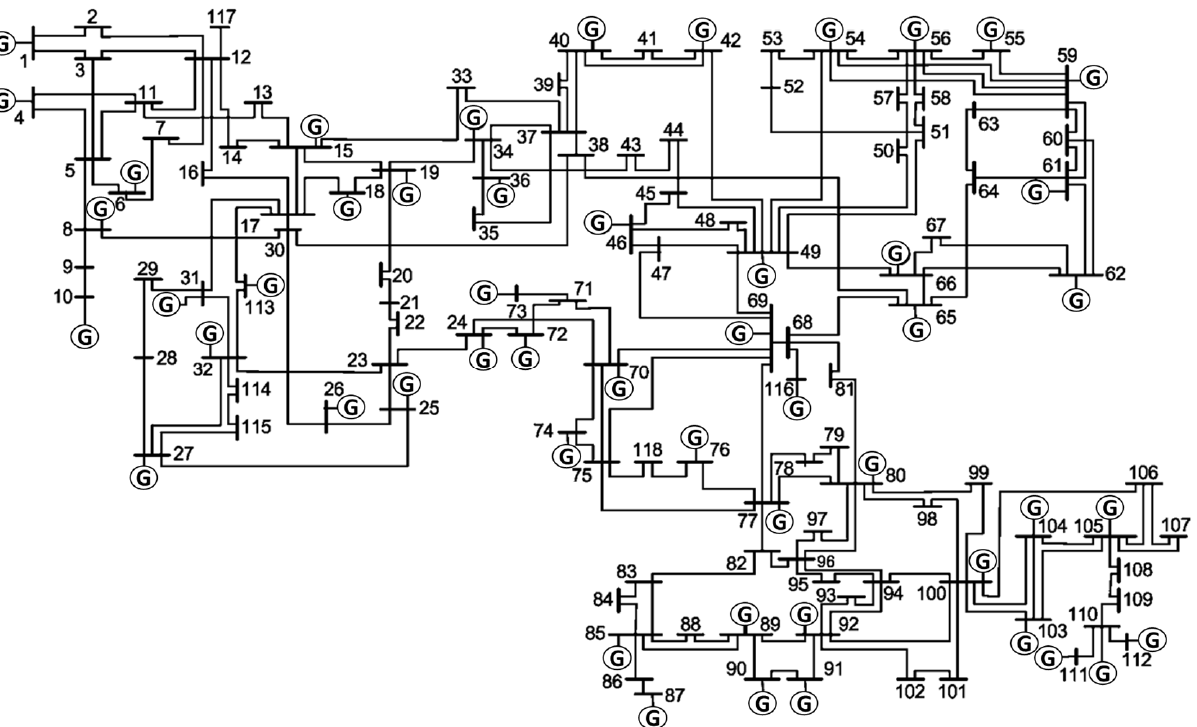
Figure 14. System Diagram (IEEE 118-Bus System).